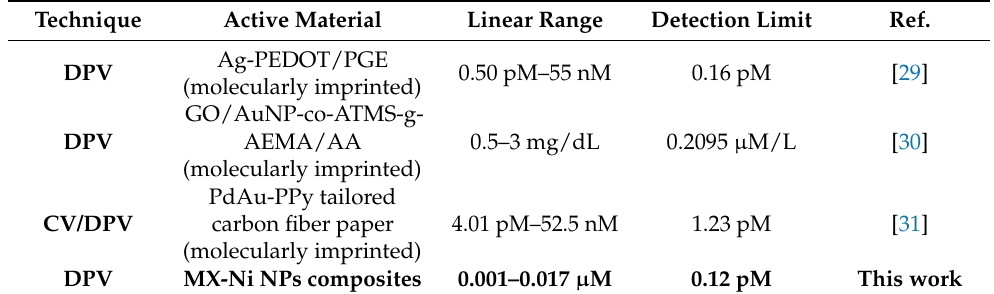
Table 1. Comparison of MX-Ni-based electrochemical sensor’s analytical parameters for MMA with recently reported competitive